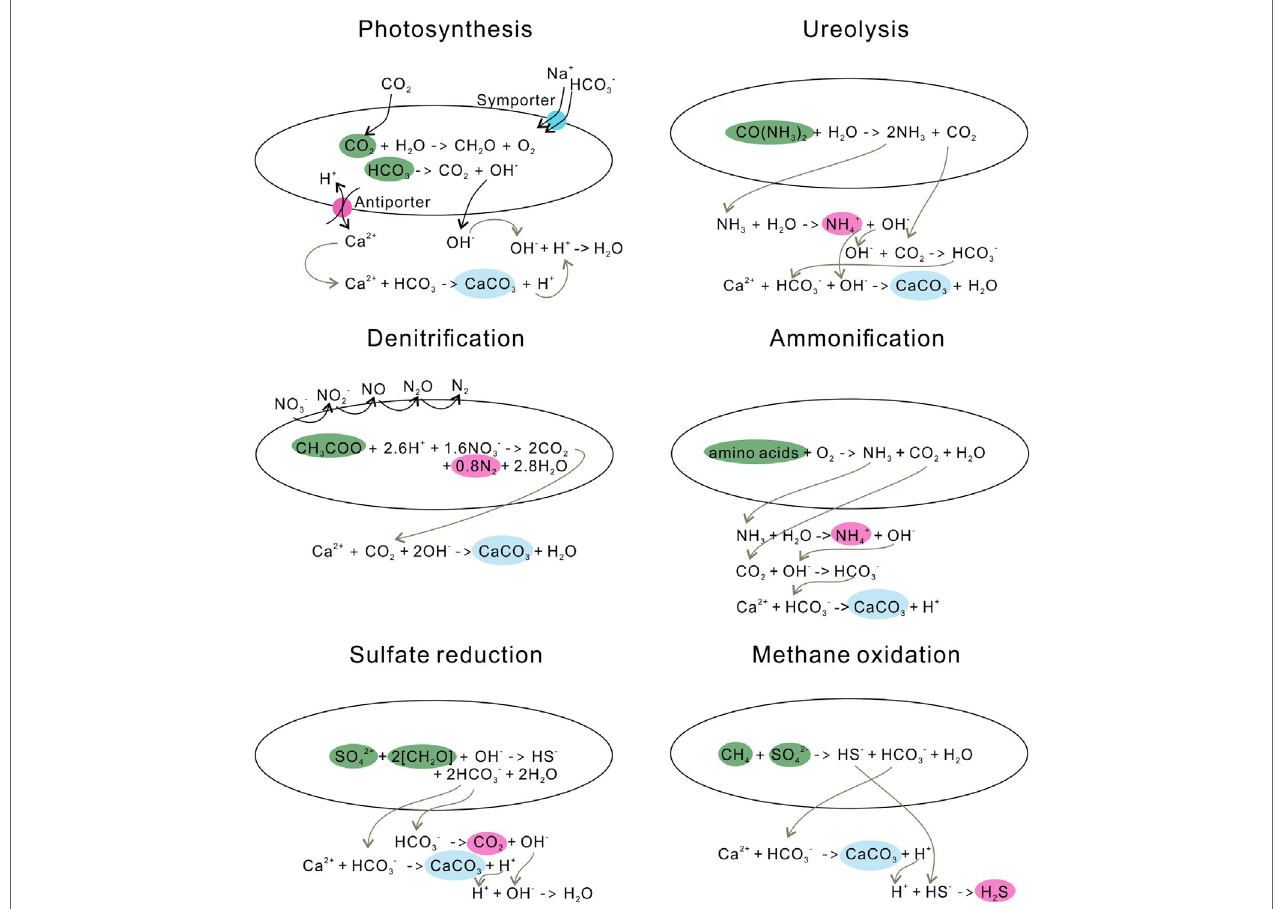
FiGURe 3 | Microbial carbonate precipitation induced by different